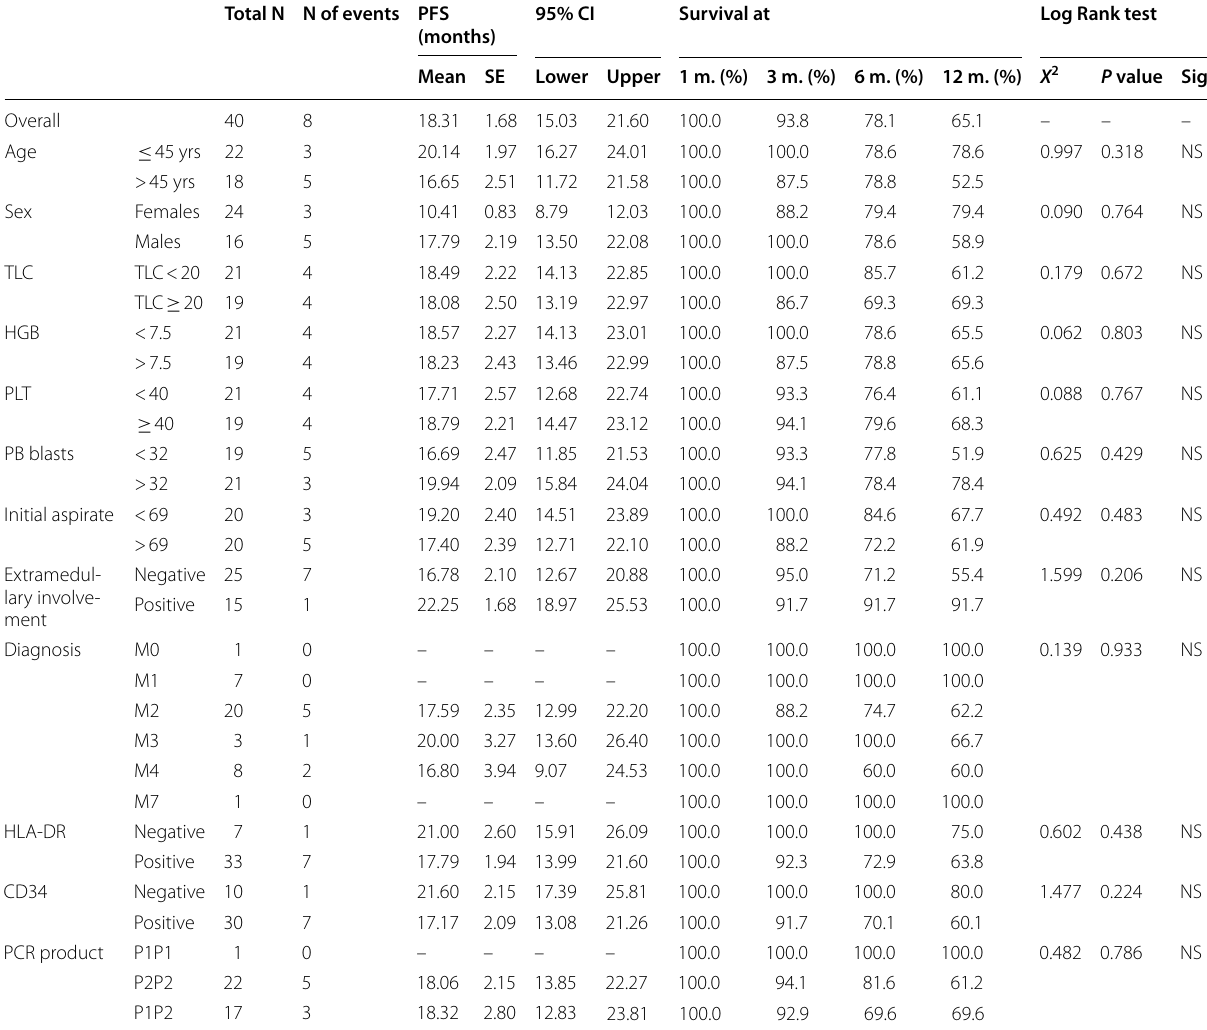
Table 7 Correlation of progression free survival with other variables Total N N of events PFS